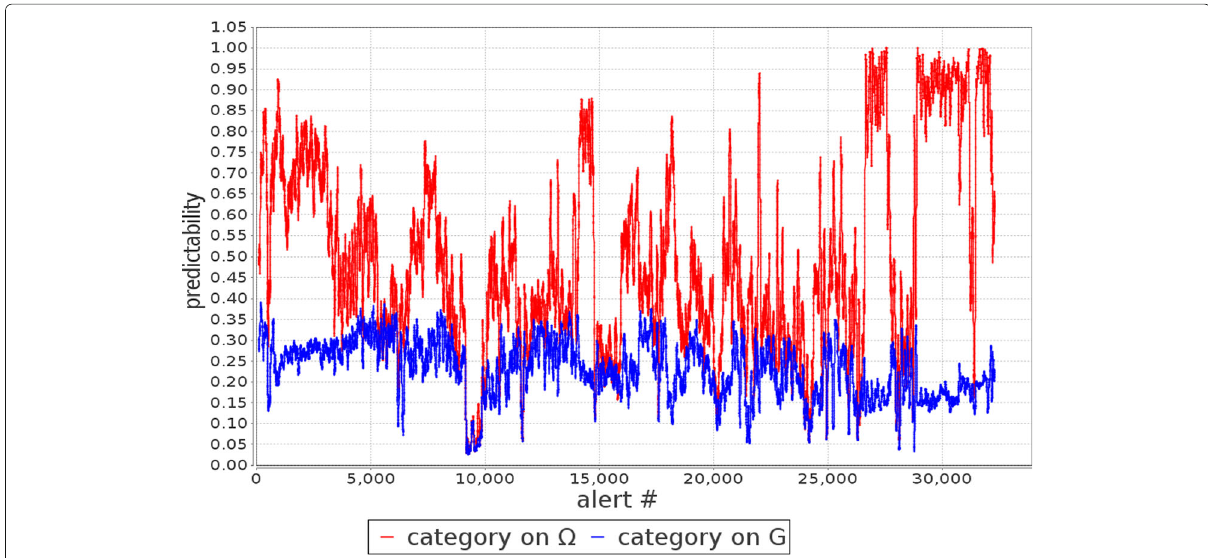
Fig. 9 The ˜ p n ((cid:2)) and ˜ p n ( G ) for alert category as the alerts come into the